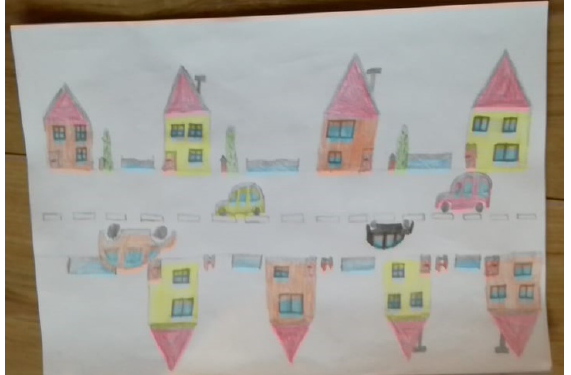
Figure 19. Combination of two front views.